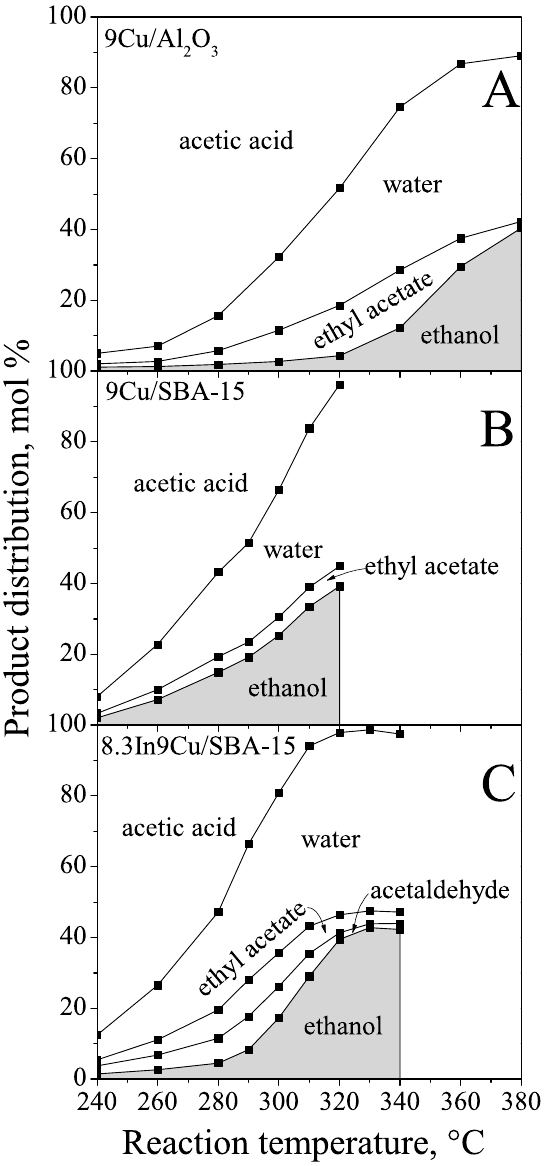
Figure 2 : Product distribution of AA hydroconversion as a function of reaction temperature over monometallic (a) Pt/Al O , (b) Cu/SBA-15 and bimetallic (c) InCu/ and bimetallic (c) InPt/SBA-15 catalysts at 21 bar total pressure and 2 3 /g × h WHSV. 1 g /g × h WHSV using stacked area AA cat. AA cat.